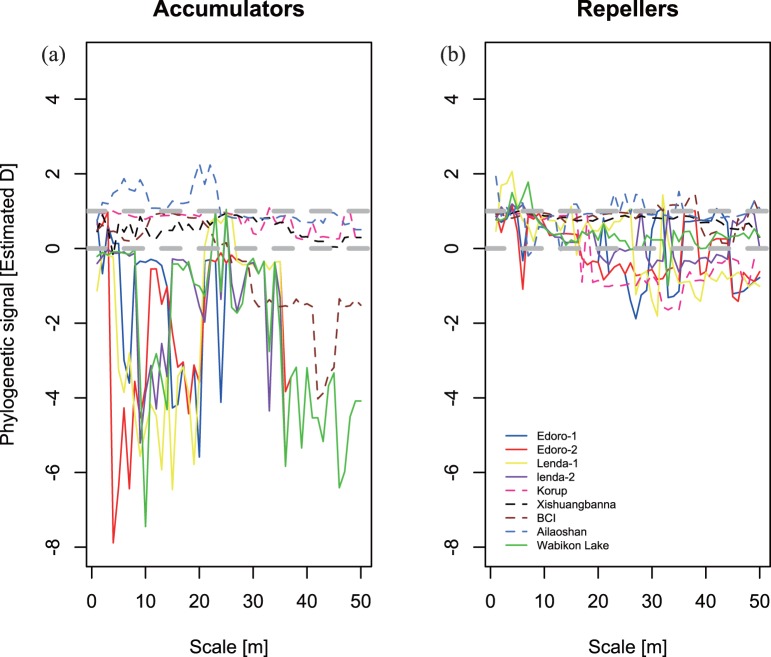
The phylogenetic signal of species diversity accumulators and repellers on each scale from 0–50 m in the nine forest dynamics plots, using D statistic developed by Fritz and Purvis (2010).Grey horizontal lines represent random expectation (D = 1) and Brownian expectation (D = 0).